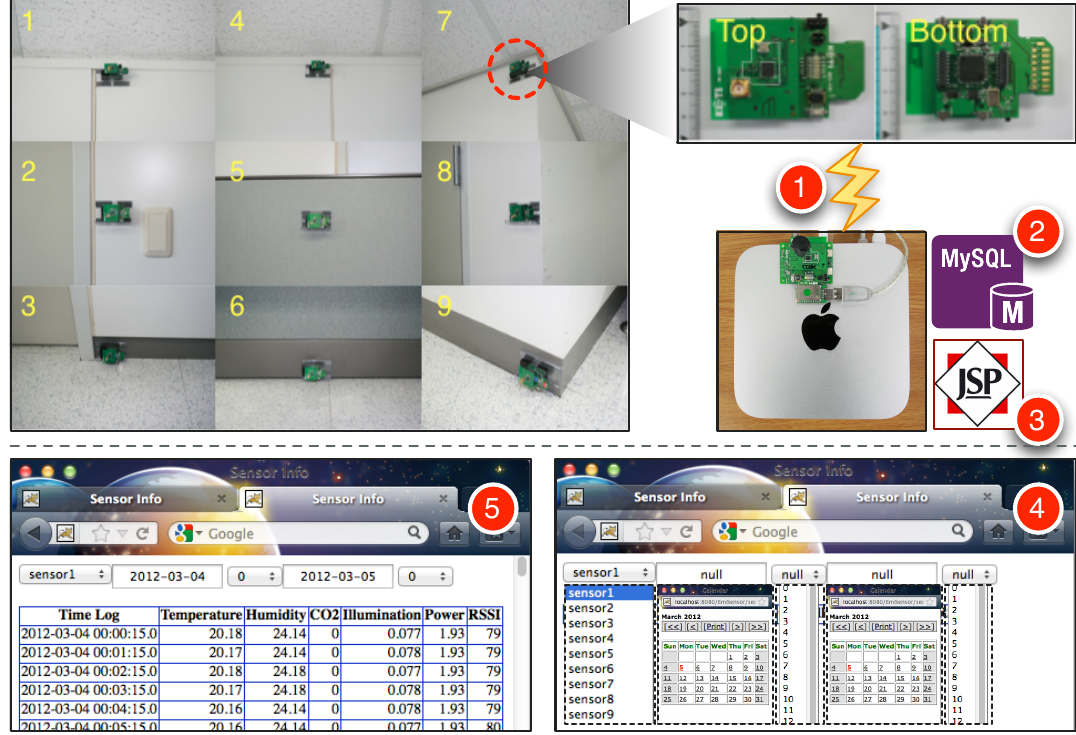
Figure 2. Our experimental setup of nine wireless sensor nodes mounted on our laboratory’s wall. (1) A wireless sensor node transmits captured data to the sink node connected to the Mac mini; (2) a Java-based logging program puts the received data into the MySQL database table; (3,4) a JSP-based Web page provides a user interface for selecting the sensor, the